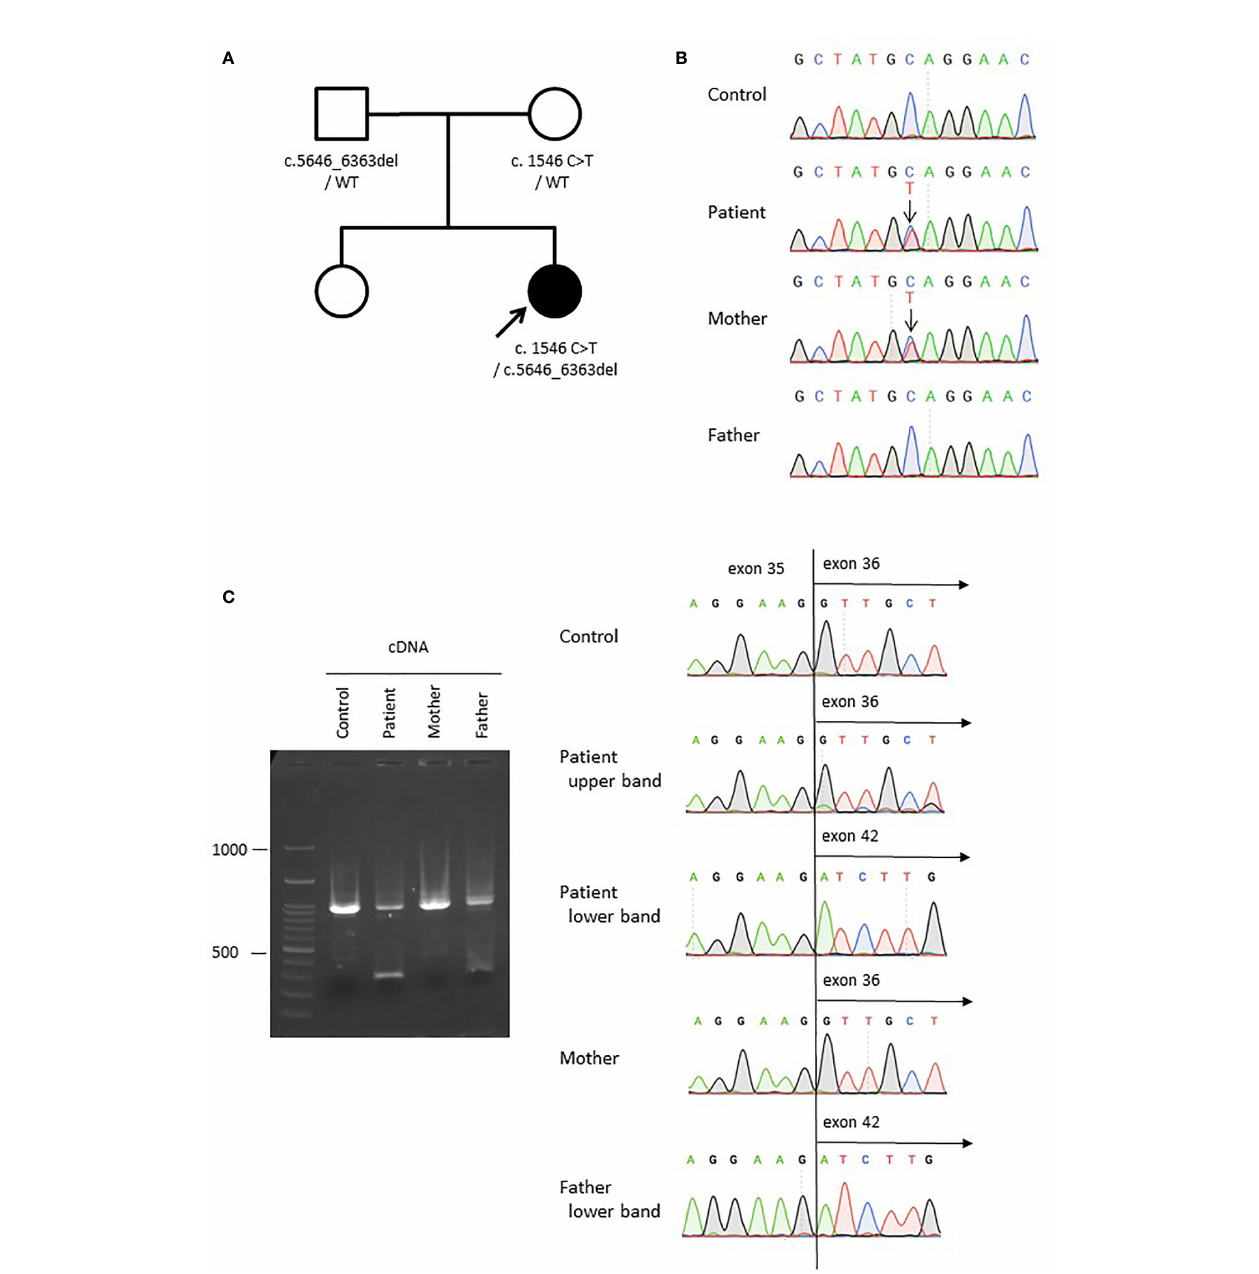
FIGURE 2 | Compound heterozygous germline LRBA mutations. (A) The pedigree of the family. (B) Sanger sequencing of genomic DNA from the patient, mother, and father. A change from C to T was detected (c.1546C>T, p.Gln516) in the patient and her mother. (C) Sanger sequencing of LRBA cDNA from the patient, mother, and father, showing a large deletion from exon 36 to 41 (c.5646_6363del) in the patient and her father. The LRBA cDNA sizes are 988 bp for the wild-type allele but 270 bp for the mutant allele lacking exons 36 –